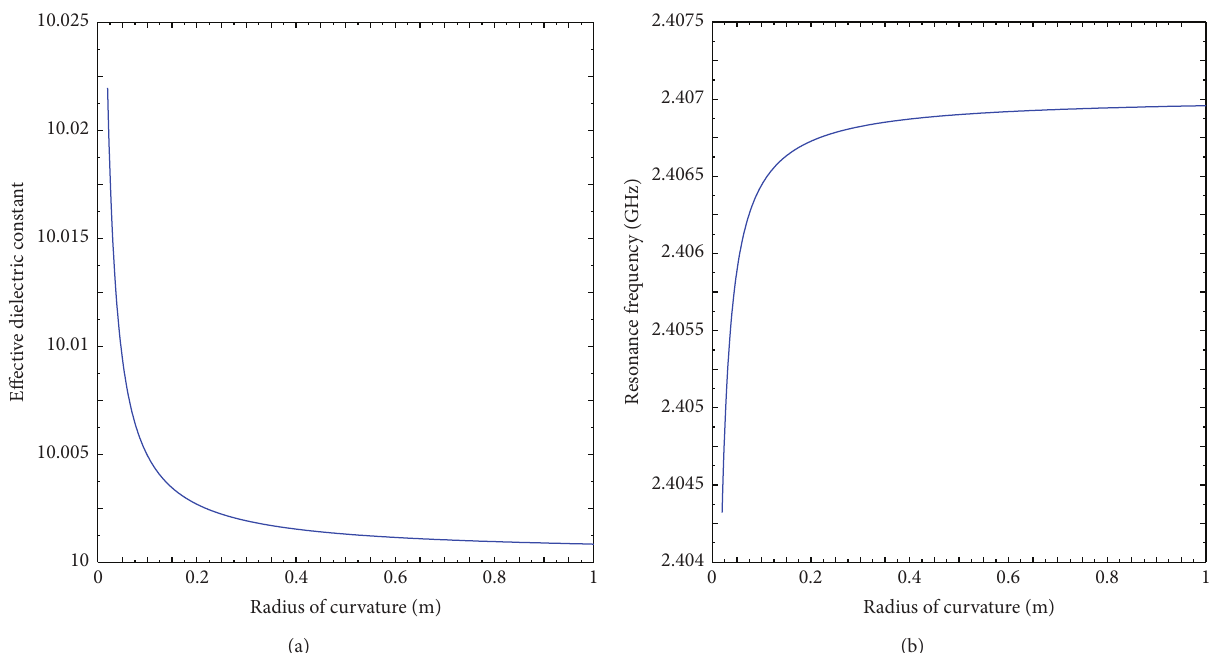
Figure 5: Impact of changing radius of curvature of a circular microstrip patch (a) on the effective dielectric constant and (b) on the resonance frequency. “Epsilam-10 ceramic-filled Teflon substrate.”